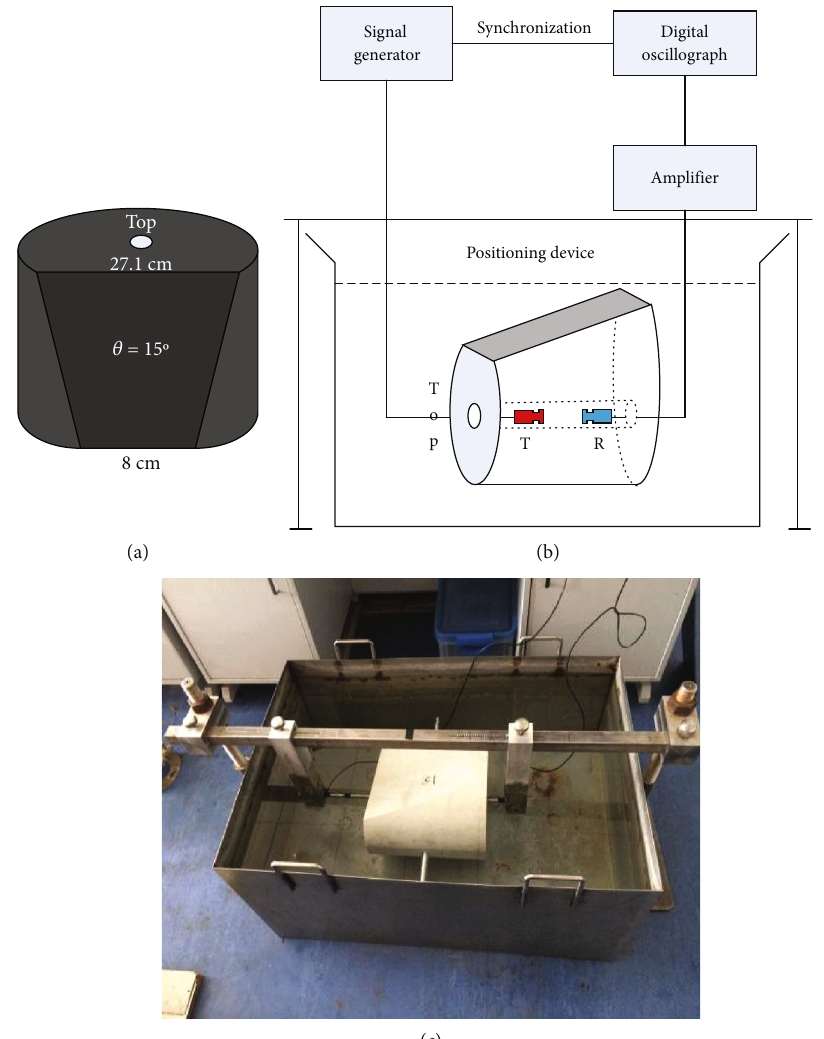
Figure 2: Physical photos and schematic diagram of the experimental device. (a) The scale model well with a re fl ection. (b) Schematic diagram of experimental device. (c) Physical drawing of the experimental device.